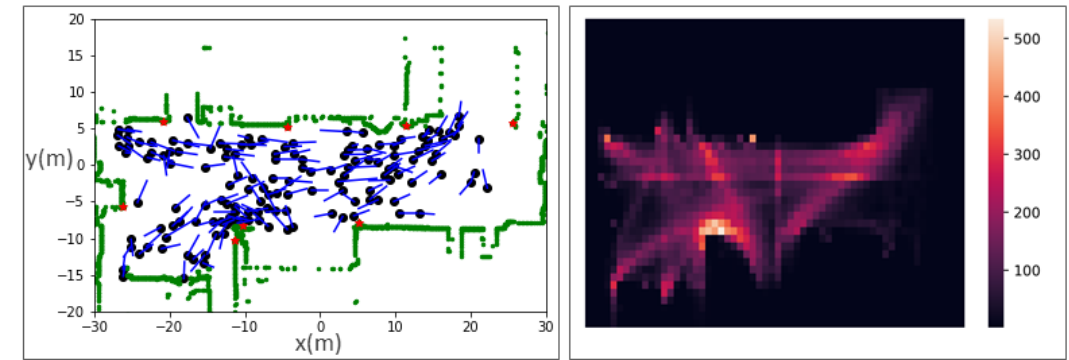
Figure 1. Global scenarios for the data used: ( left ) the green part is the background, each black dot is a pedestrian, the blue part is the pedestrians’ current walking phase, and red points are sensor locations; ( right ) heatmap of the scenarios. Warmer color implies higher pedestrian occupancy frequency.